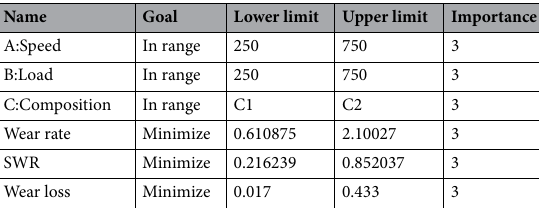
Table 8. Numerical optimization constraints and target